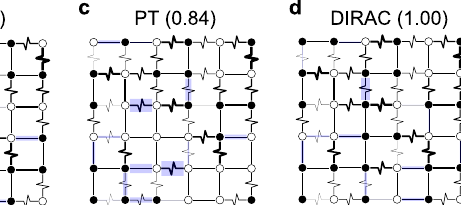
bond, − J ij s i s j ,ispositive,namelynotsatis fi ed,wedrawalightblueshadedrectangle around the bond, with width proportional to ∣ J ij ∣ . This way a smaller total shaded area of the image corresponds to a lower system energy. We also showed the approximate ratio (prediction/ground truth, where the numerator is the energy of the predicted ground state computed by eachmethod and the denominator is the exact ground state energy computed by Gurobi, a branch-and-bound based exact solver) in brackets. Note that in this small case DIRAC has actually achieved the exact ground